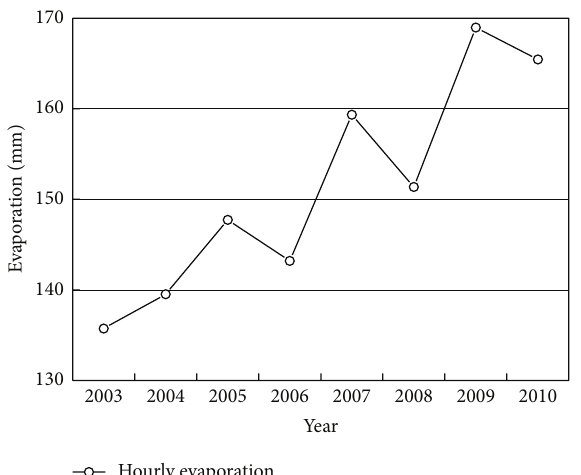
Figure2:Variationtrendsoftotalannualhourlyevaporation(13:10– 14:10) in Dongping Lake from 2003 to 2010.